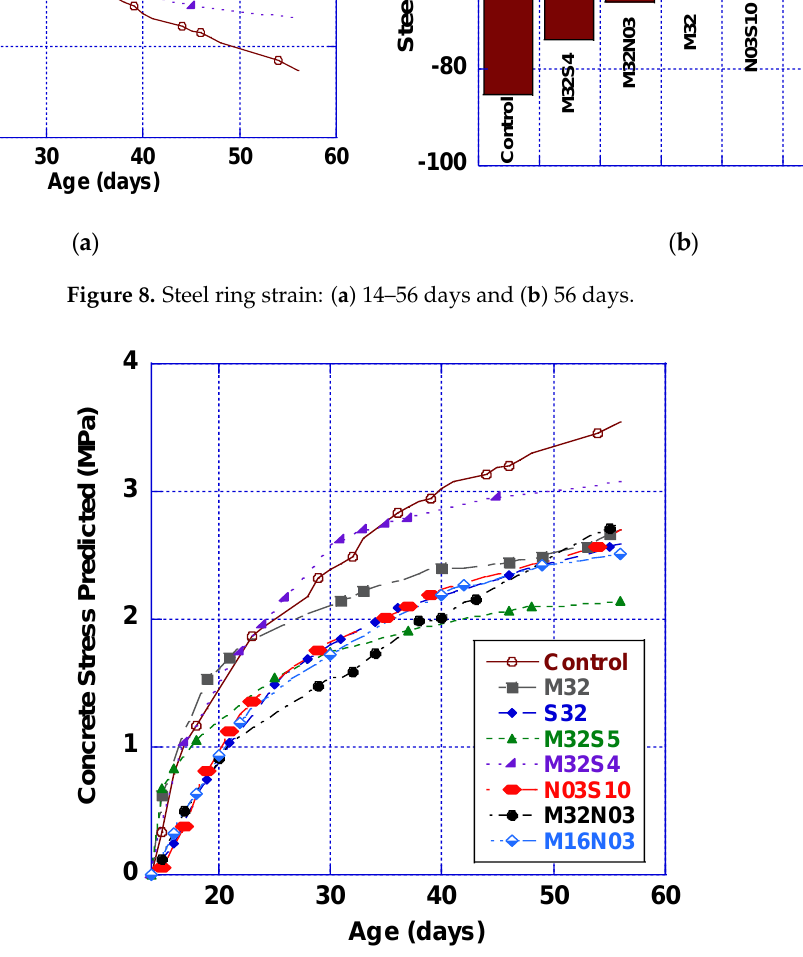
Figure 9. Prediction of the concrete stress using Hossain and Weiss ’s prediction model [42].